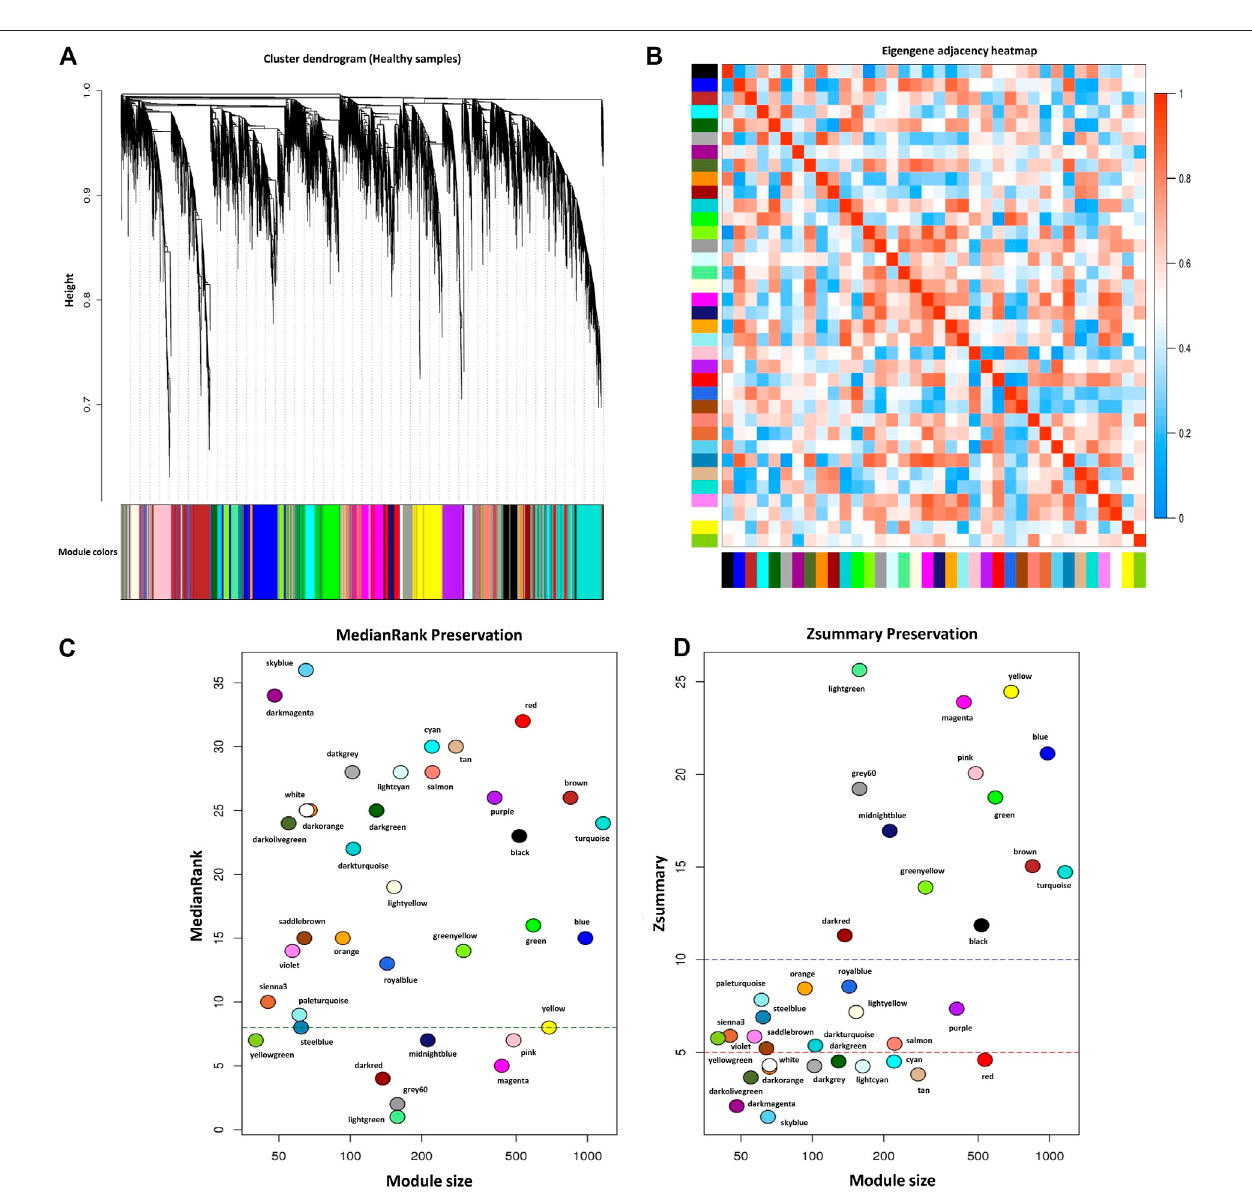
FIGURE 7 | Module preservation analysis. (A) Gene hierarchical clustering dendrogram of 36 detected modules based on a dissimilarity (1-TOM) measure across healthy samples as reference set, the y-axis represents the coexpression distance and the x-axis represents the genes. The branches indicate the modules, and each module is marked with a separate color, the gray module encompass genes that are not assigned to any of the modules. (B) Eigengene adjacency heatmap indicate relationship among all the modules. (C) The medianRank preservation statistics of the modules. The y-axis and the x-axis represent medianRank values and module size, respectively. Each point indicates a module labeled by a respective color. The green dashed line represents the medianRank threshold (medianRank ≥ 8). (D) The Zsummary preservation statistics of the modules. The y-axis and the x-axis represent Zsummary values and module size, respectively. Each point indicates a module labeled by a respective color. The red dashed line represents the Zsummary threshold (Zsummary ≤ 5). Modules with Zsummary ≤ 5 or medianRank ≥ 8 were considered as nonpreserved between healthy and BRD conditions.